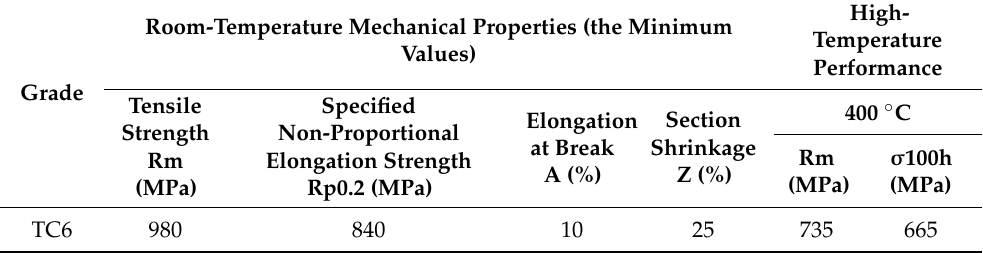
Table 1. TC6 titanium alloy